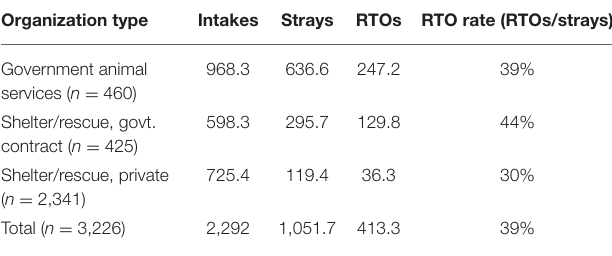
TABLE 1 | Intakes, strays, RTOs (in thousands), and RTO rates as reported to SAC, 2019. Organization